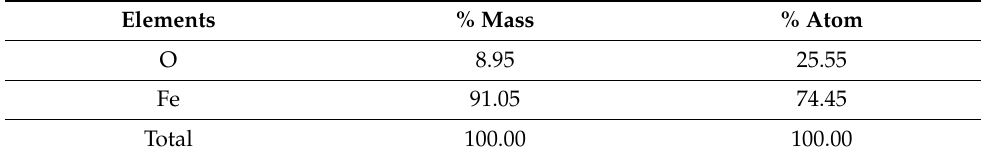
Table 2. Results of analyzing Fe sample elements.